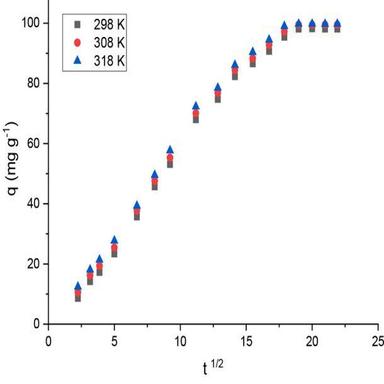
The plot of the intraparticle diffusion model.